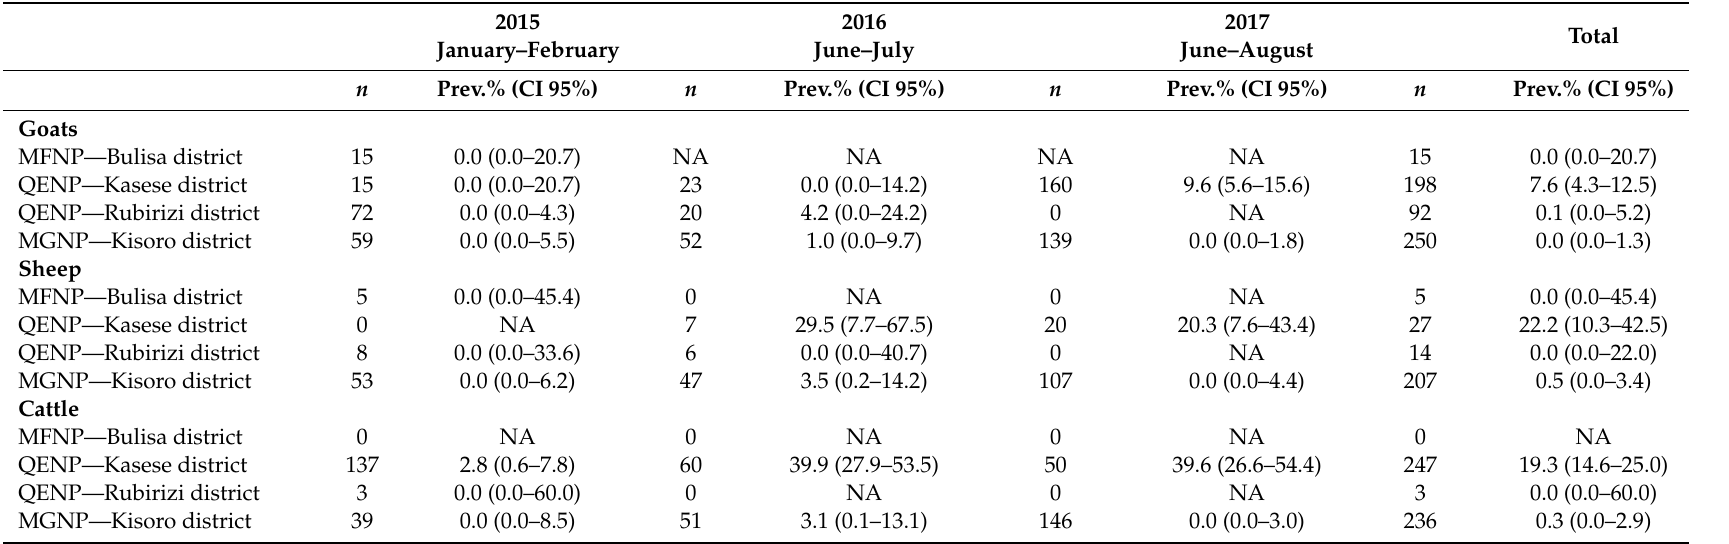
Table 2. Results of PPRV antibody detection in livestock from communities around natural protected areas in western Uganda (MFNP = Murchison Falls National Park, QENP = Queen Elizabeth National Park, MGNP = Mgahinga Gorilla National Park). The sample prevalence is estimated using specificity and sensitivity of the diagnostic test for domestic species